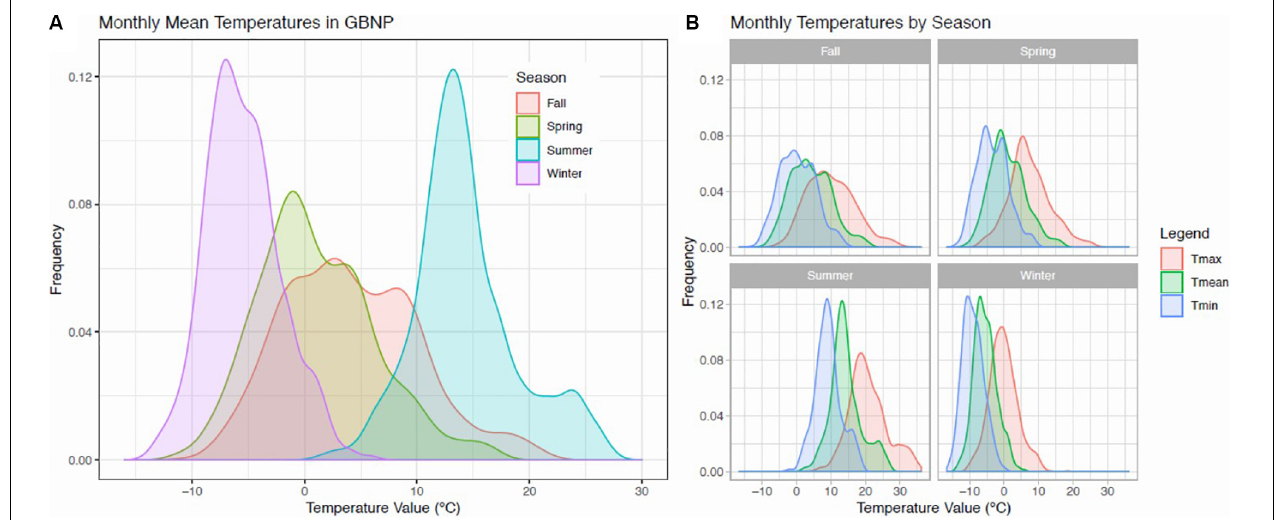
FIGURE 6 | (A) Histogram illustrating the frequency of monthly T mean across GBNP by season, including all ESN sensors; (B) Histograms displaying the frequency of mean, minimum, and maximum temperature occurrences during fall, spring, summer, and winter.